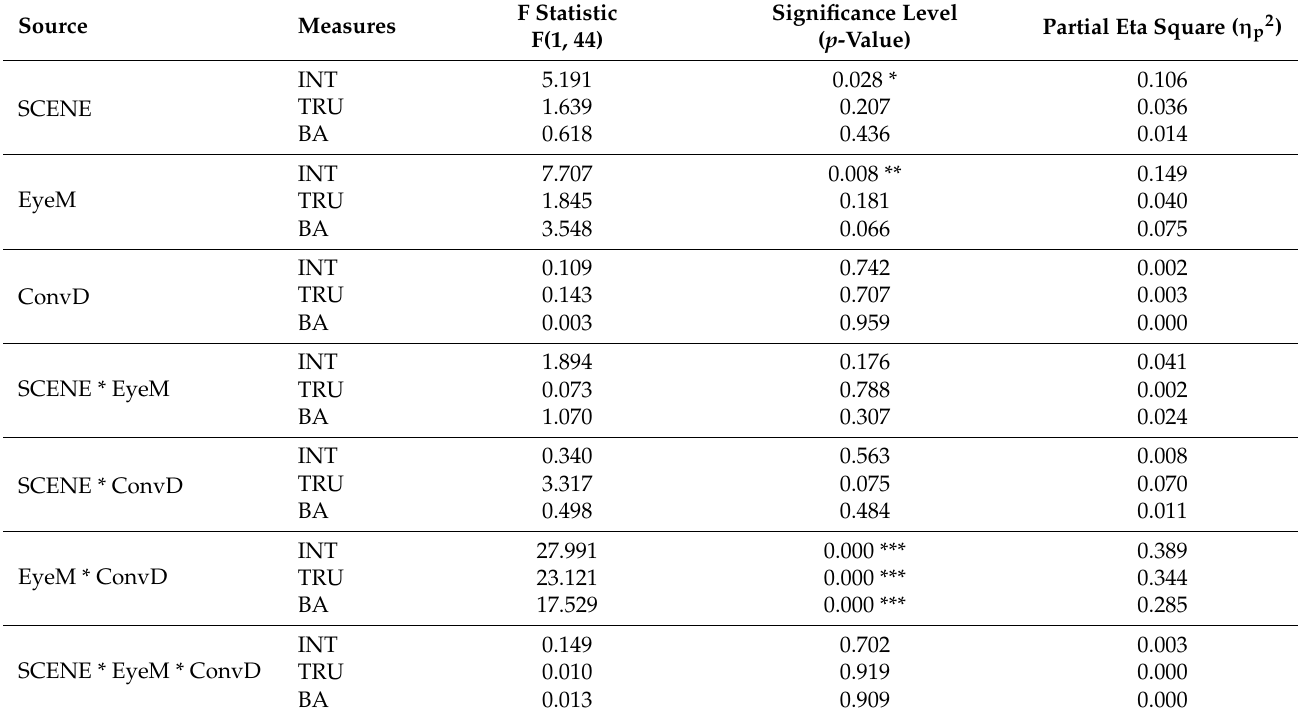
Table A10. Tests of Within-Subjects Effects for the Full Sample (N = 45).